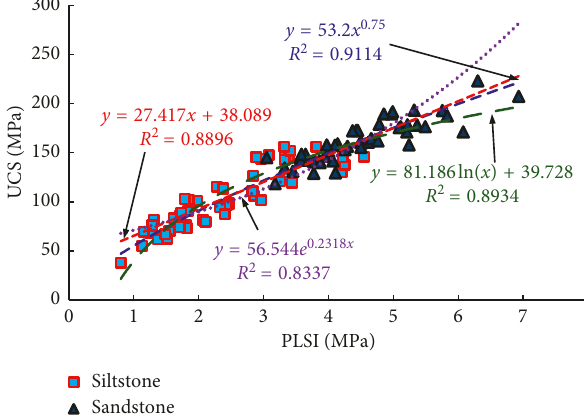
Figure 9: The relation between UCS and PLSI obtained from regression. Table 4: The summary results of correlation between UCS and PLSI.